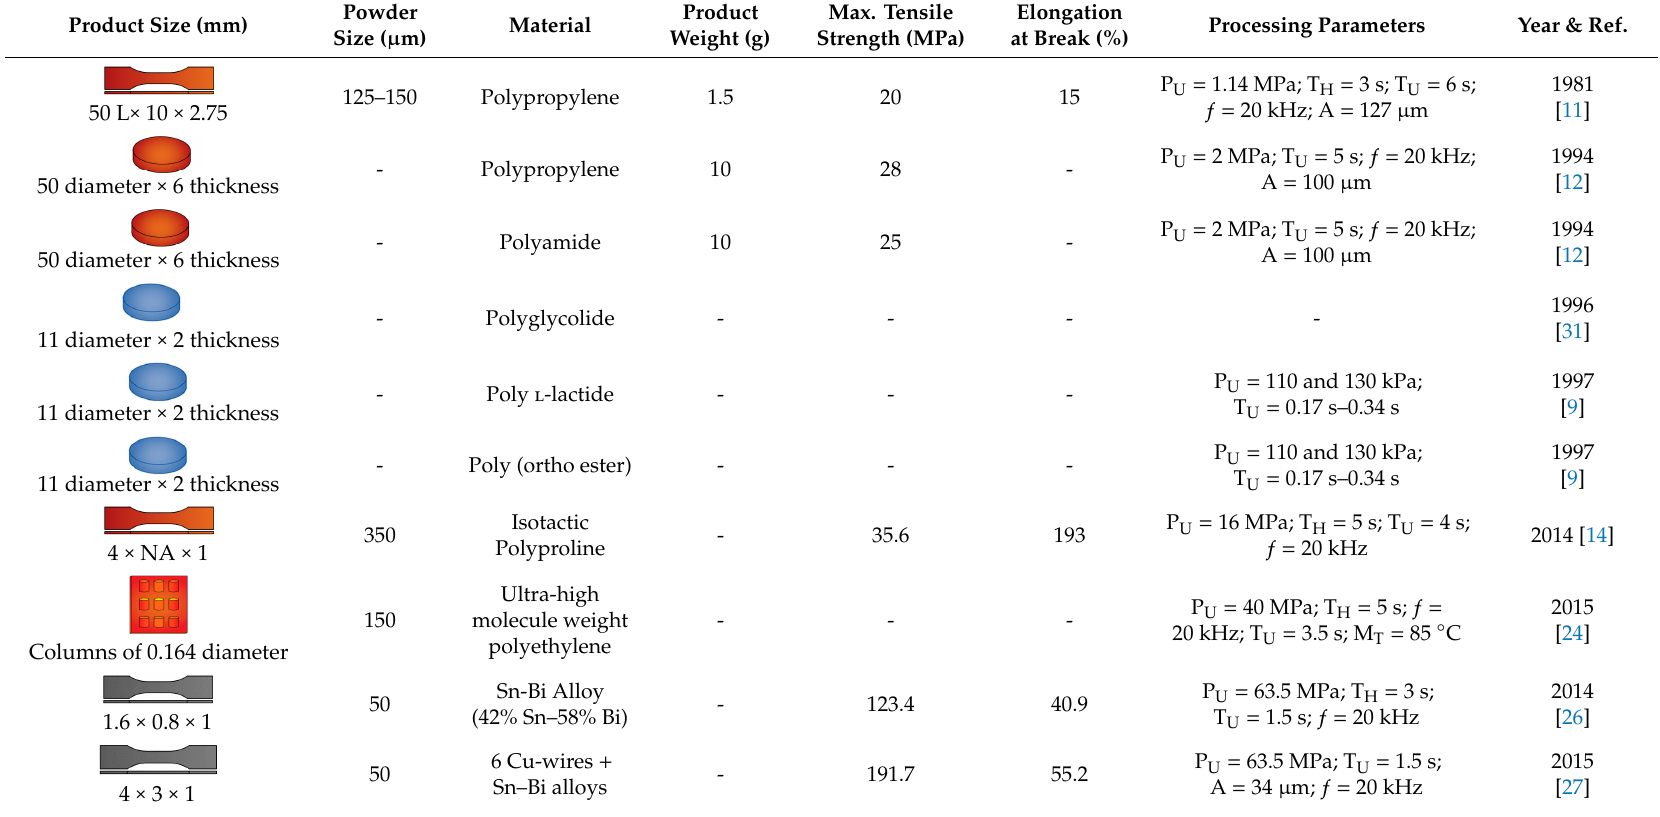
Table 1. Example of materials processed by UCM.